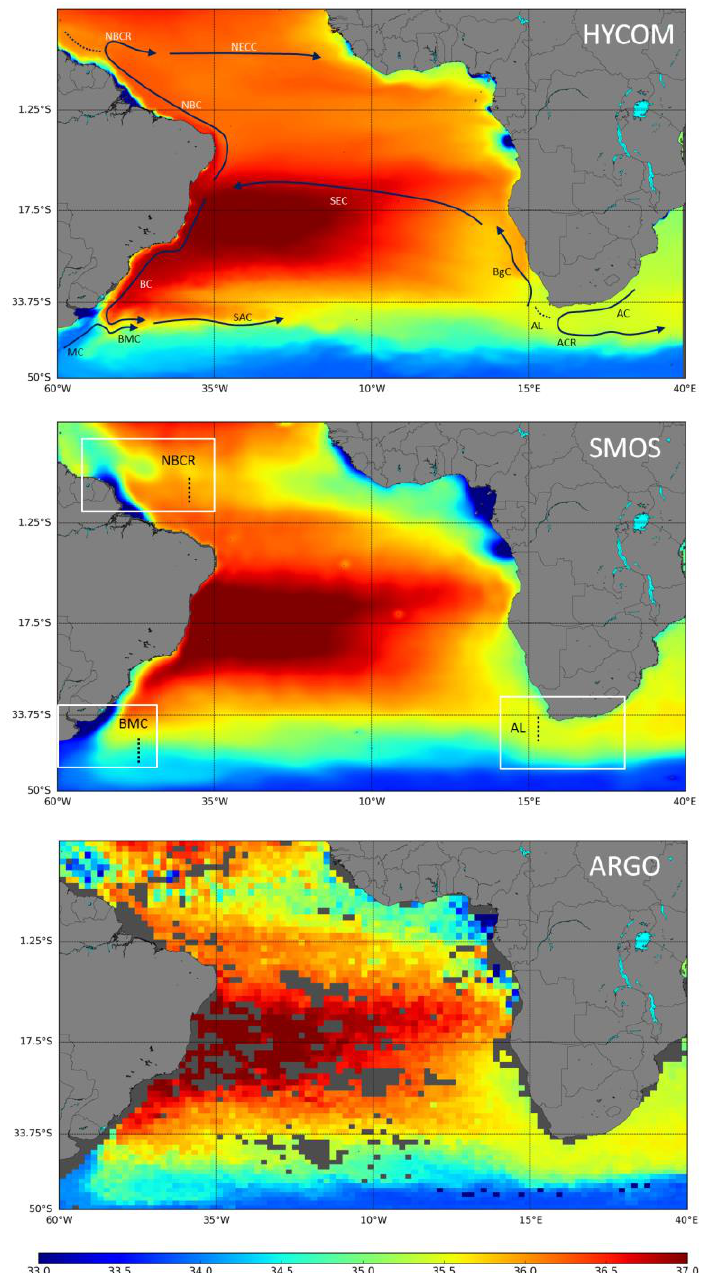
Figure 1. Mean sea-surface salinity (SSS) from January 2011 to December 2015 for ( top panel ) Hybrid Coordinate Ocean Model (HYCOM) at 1/12 ◦ resolution, ( middle panel ) Soil Moisture Ocean Salinity (SMOS) at 1/4 ◦ resolution, and ( bottom panel ) Argo at 1 ◦ resolution. The top panel shows a scheme of sea surface currents, highlighting those features relevant to our study: North Brazil Current (NBC), North Brazil Current Retroflection (NBCR), North Equatorial Countercurrent (NECC), South Equatorial Current (SEC), Brazil Current (BC), Malvinas Current (MC), Brazil-Malvinas Confluence (BMC), South Atlantic Current (SAC), Benguela Current (BgC), Agulhas Current (AC), Agulhas Current Retroflection (ACR), and Agulhas Leakage (AL). The middle panel includes rectangles that locate our three study areas, with dotted lines denoting the sections used for the zonal transport calculations.